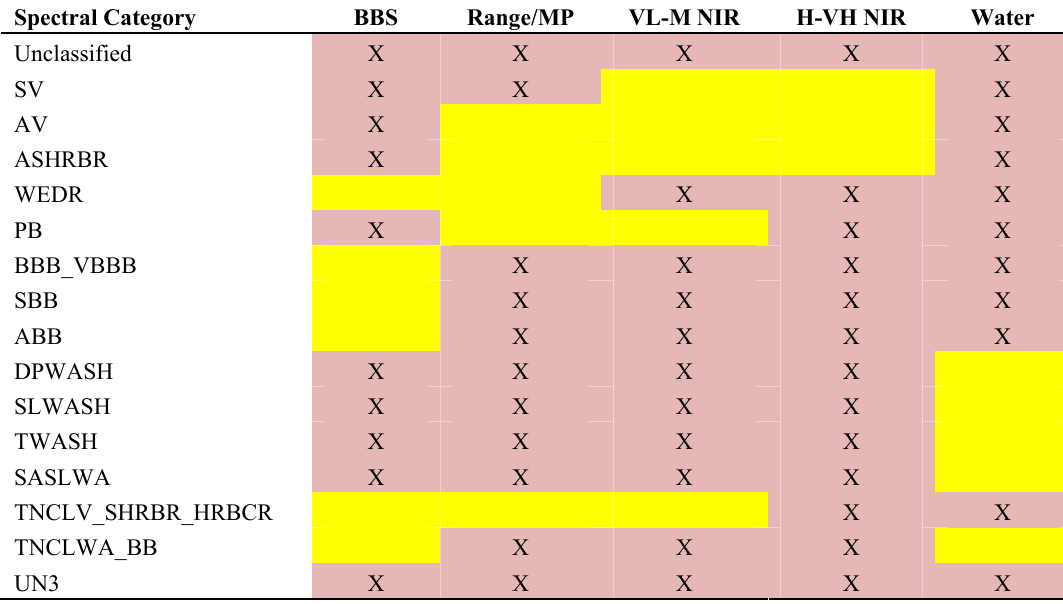
Table 11. Intermediate-granularity S-SIAM™ pre-classification of the SPOT test image. OAMTRX instance between test classes (related to those shown in Table 3) and reference classes (refer to Table 6), represented as table rows and columns respectively. For the sake of simplicity, only test classes (table rows) whose occurrence is greater than 0.15% in the test map being investigated are shown. “Correct” entries selected by the present authors for inter-vocabulary reconciliation are shown as yellow